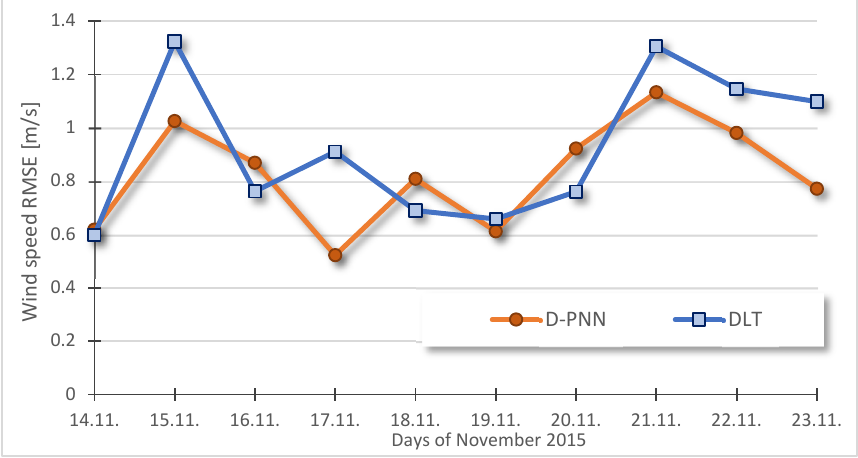
Figure 9. 10-day wind-speed avg. day prediction RMSE: DNN = 0.826, DLT = 0.925 [m/s].